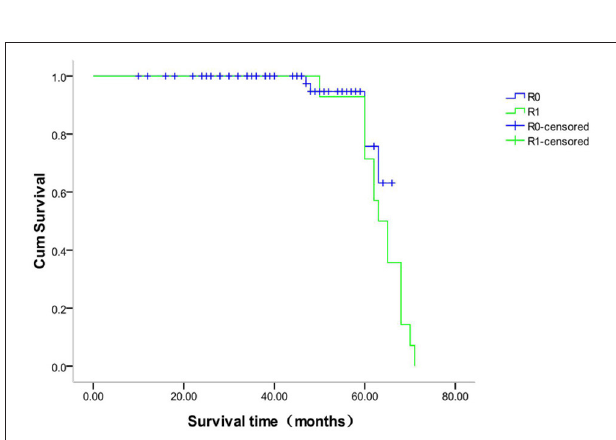
FIGURE 8 | Survival curve of patients with different surgical margins after non-anatomical